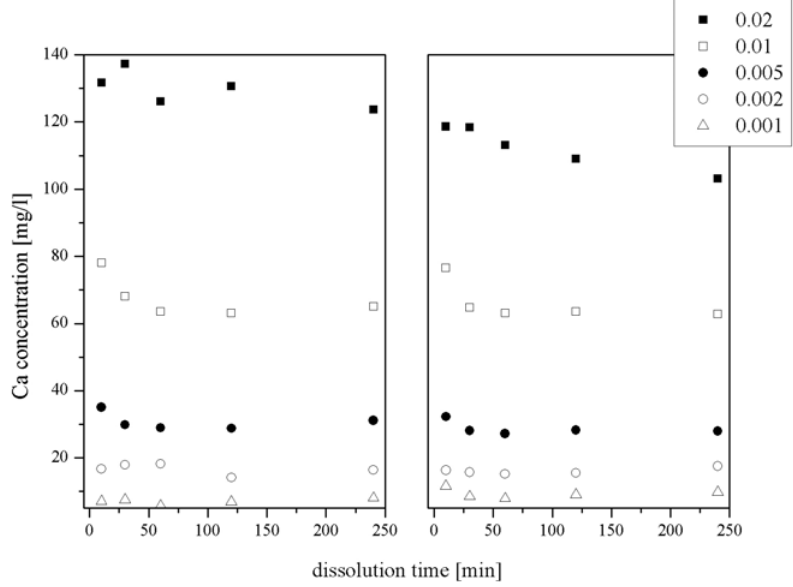
Figure 1. Ca concentrations in (a) L -glu and (b) L -asp solutions depending on the dissolution time. Overall Ca concentrations in (a) L -glu solutions were slightly higher overall compared with those in (b) L -asp